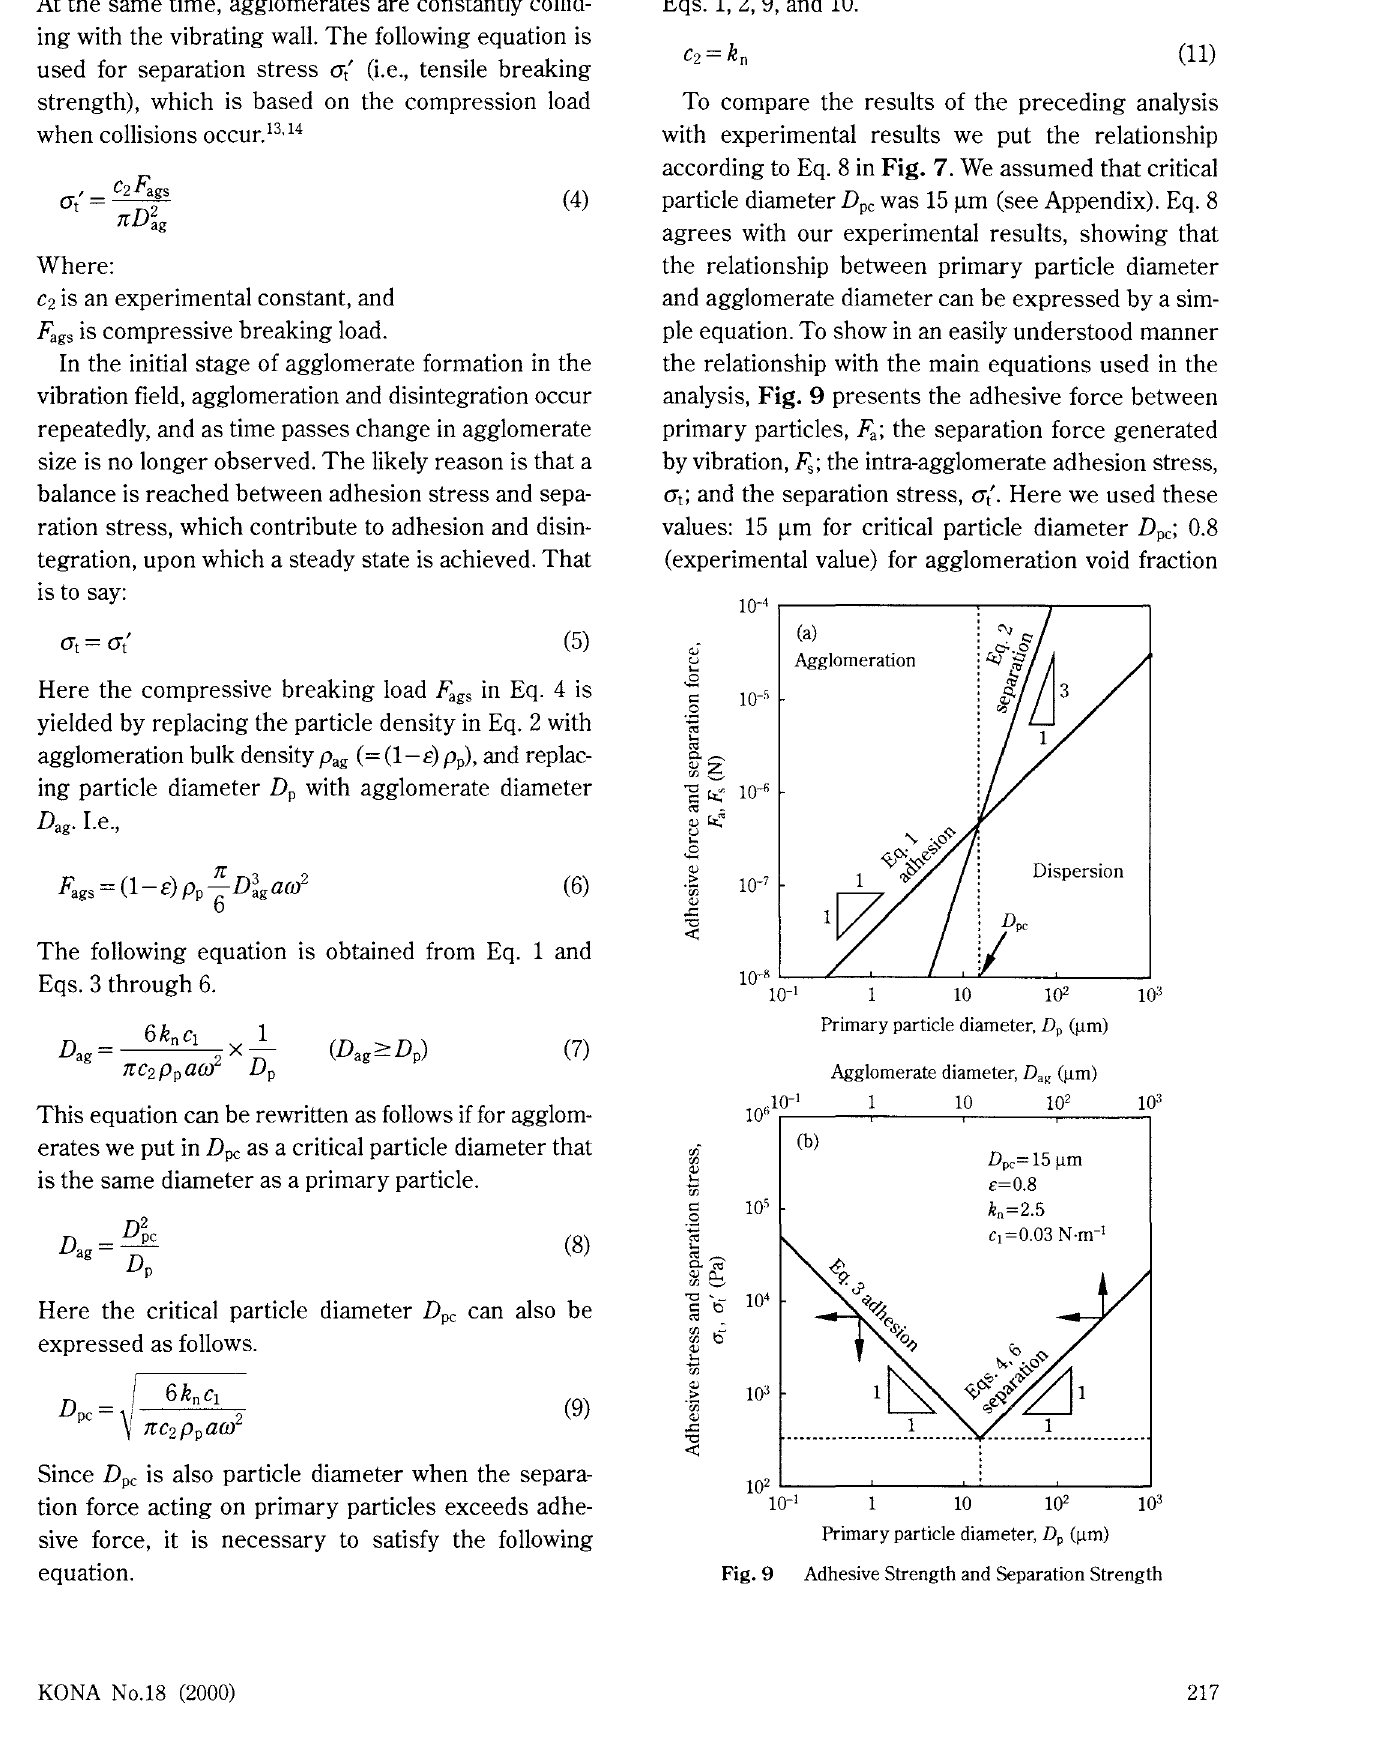
Adhesive Strength and Separation